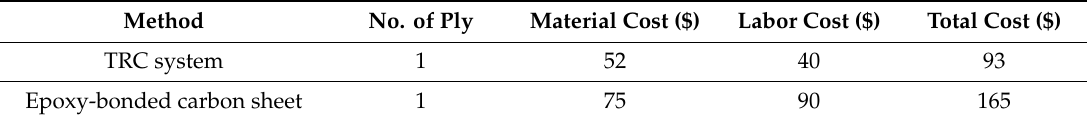
Table 7. Summaryofthematerial, labor, andthetotalcostoftheflexuralstrengthening(costunits,US$ / m 2